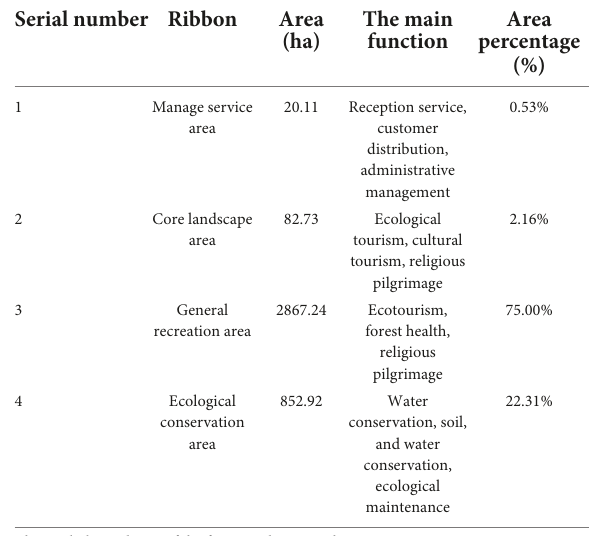
TABLE 3 Functional zoning table of forest